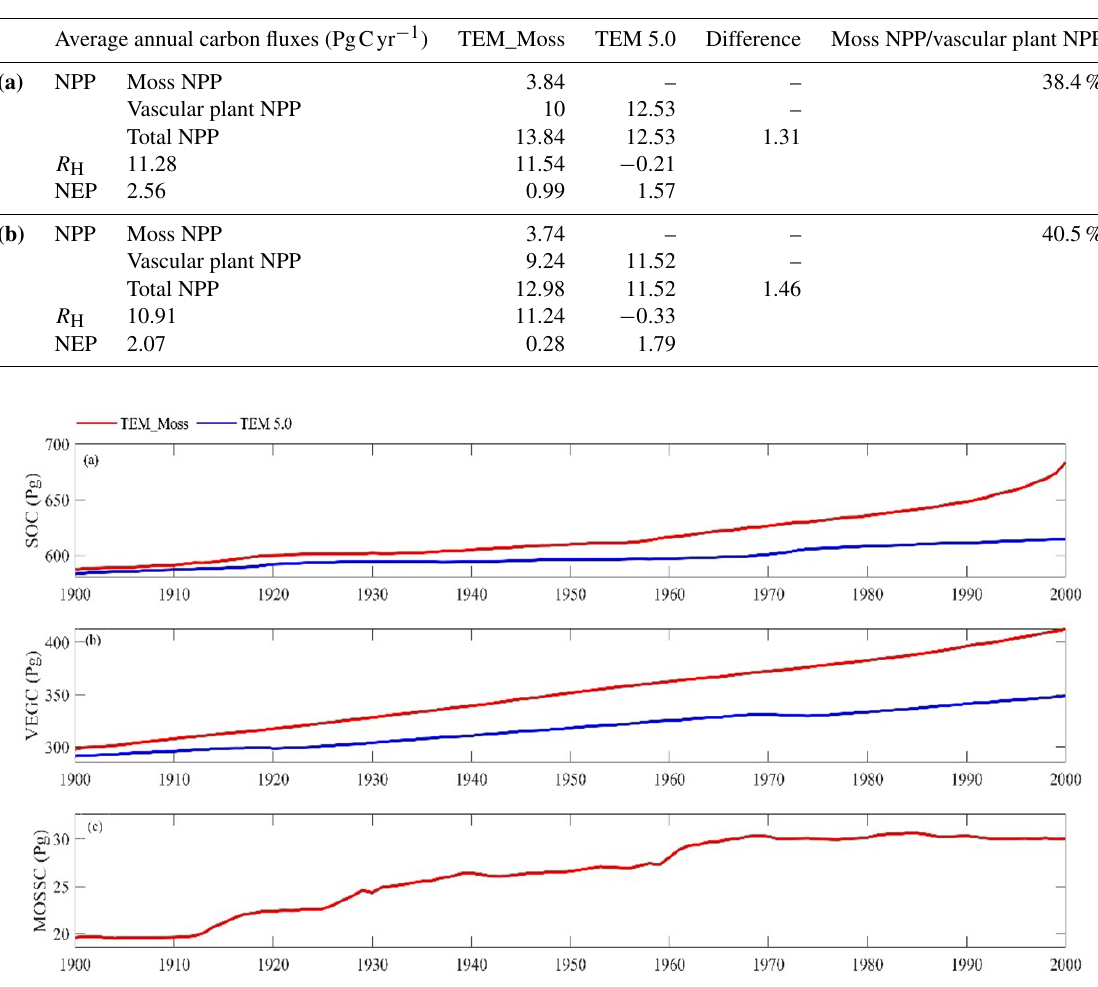
Table 11. Average annual NPP, R H , and NEP (as PgCyr − 1 ) during the 21st century estimated by two models under the (a) RCP8.5 scenario and (b) RCP2.6 scenario.